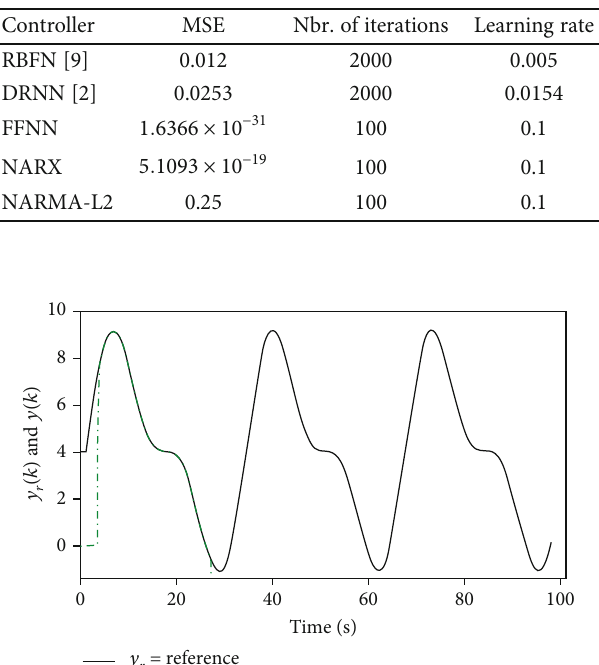
Table 1: Comparison of the performance index of the proposed controller and other controllers (example 1).